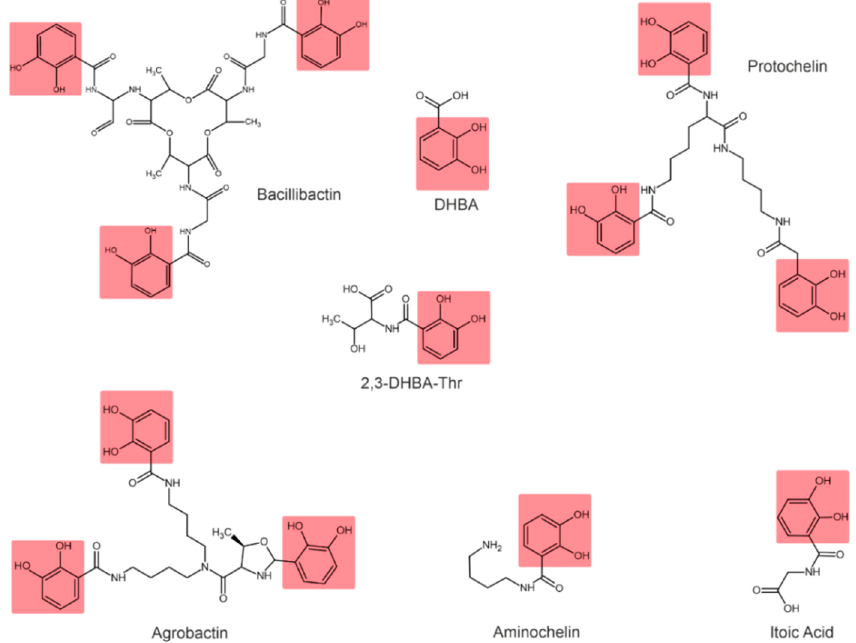
Figure 2. Examples of catecholate-type siderophores. Catecholate functional groups are highlighted in red.